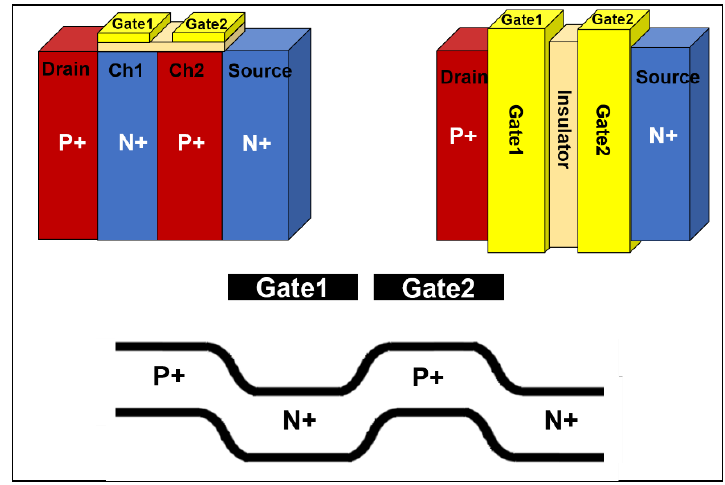
Figure 6. Structure and energy band diagram for the dual gate FBFET with PN junction barriers [75].